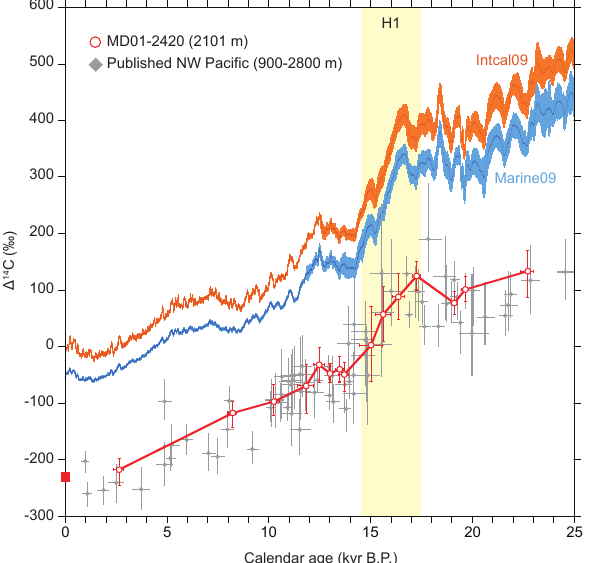
Fig. 2. Age-depth plot for core MD01-2420 showing radiocarbon ages from planktic foraminiferal species Globigerina bulloides and Globorotalia inflata and benthic foraminiferal Uvigerina spp. and mixed benthic foraminiferal species.